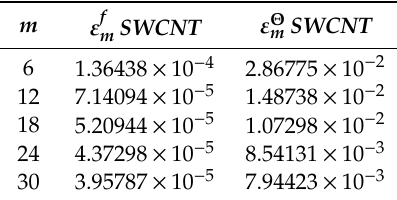
Table 2. The total sum of the averaged squared residual errors for the SWCNTs . When Pr = 6.7, M = Re = 0.1, φ = 0.01.